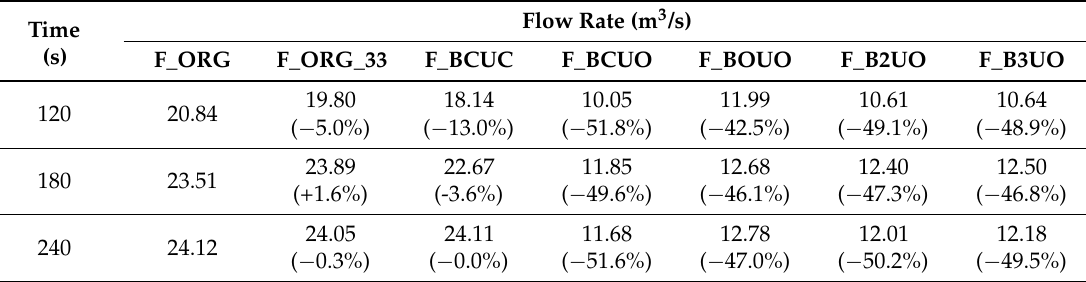
Table 9. Flow rate of the air outlet (Exhaust-L).